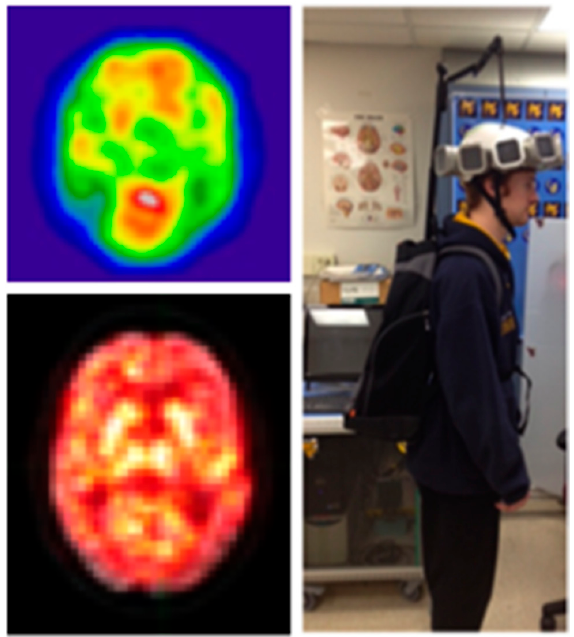
Figure 6. Image from the Generation 0 scanner showing a 2 mm thick brain slice after 1 min of acquisition during purposeful head rotation using ~2–3 mCi (9–12 mCi injected; imaged after 2 half-lives) of 18 F-fluorodeoxyglucose. Elevated activity (in red) in the occipital cortex, frontal lobes, and head of the caudate can be easily identified, left top. Different 2 mm slice acquired over 10 min overlaid onto a clinical PET scan. Note the strength of signal in the head of the caudate, thalamus, and occipital region, left bottom. Original concept of the ultimate mobile imaging. Basic electronics could be stored in a backpack with backpack mounted support system taking some weight off the head, right.